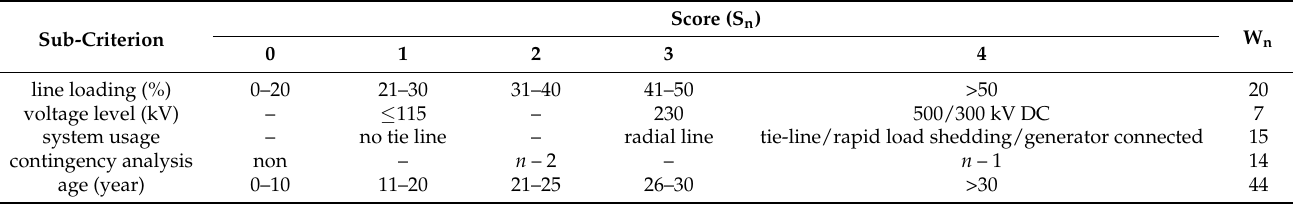
Table 7. Score and weight for safety/reliability